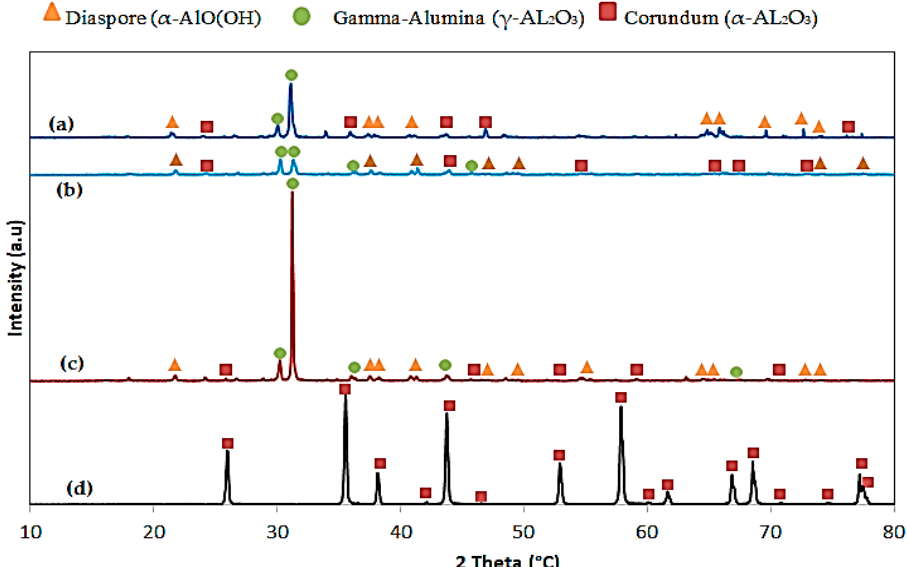
Figure 2. XRD pattern comparing the effect of reaction times on synthesis of Alumina; ( a ) AL-6-30, ( b ) AL-12-30, ( c ) AL-24-30 and ( d ) AL-Commercial. Diaspore, corundum, and gamma-alumina in the synthesis of alumina were de-